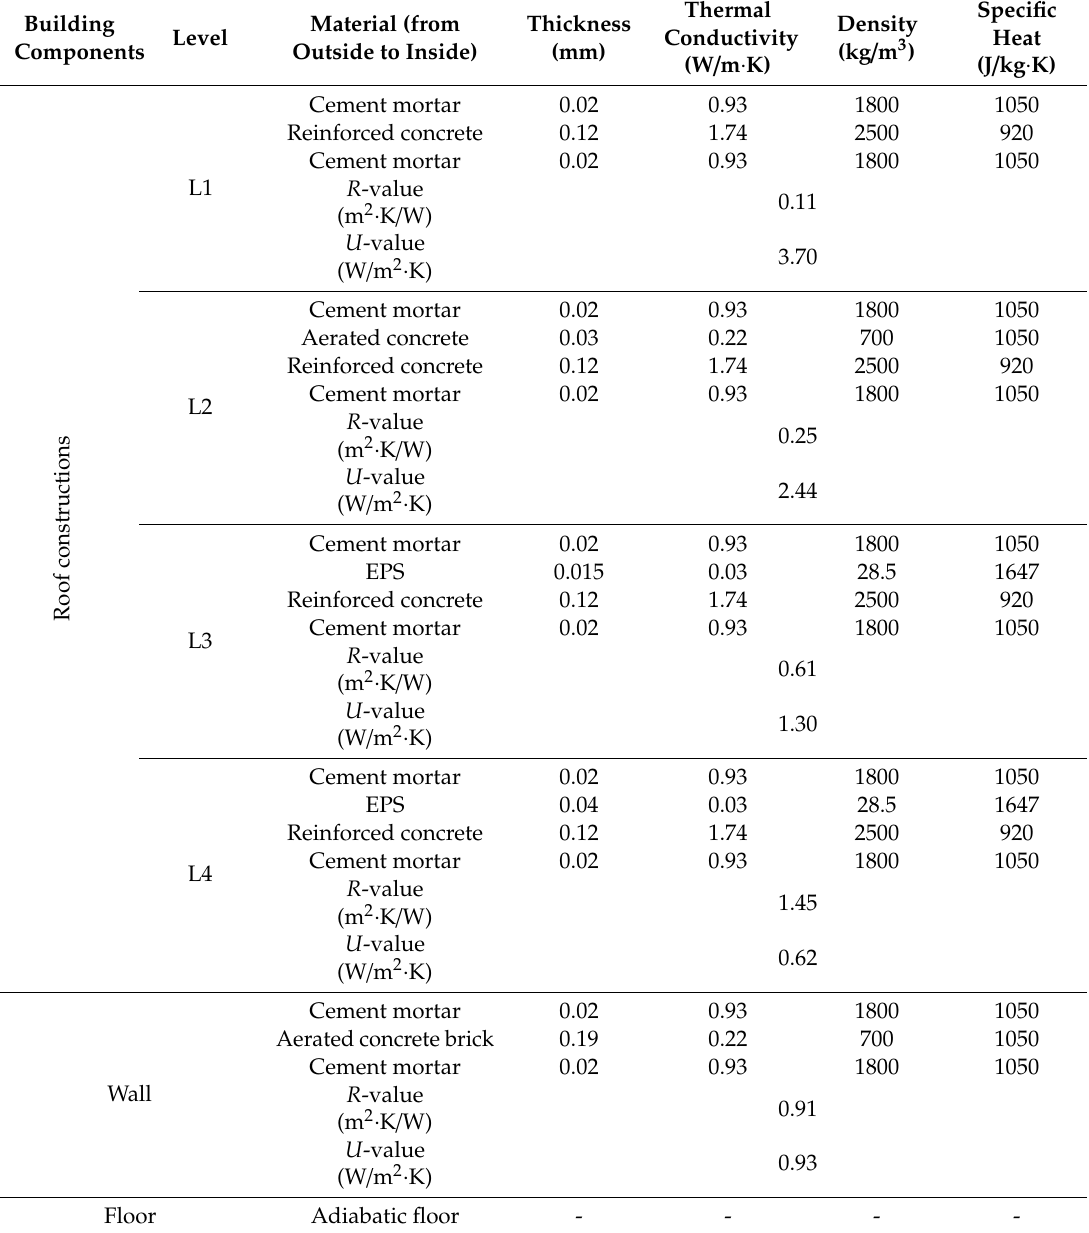
Table 6. Building materials and their thermophysical